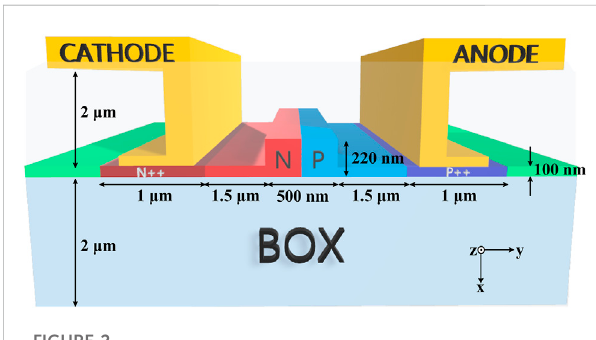
FIGURE 2 3D front view of the silicon phase shifter (not to